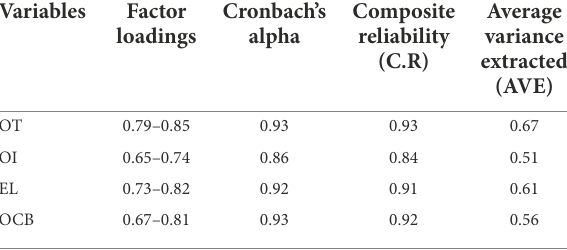
TABLE 1 Factor loadings of variables and overall